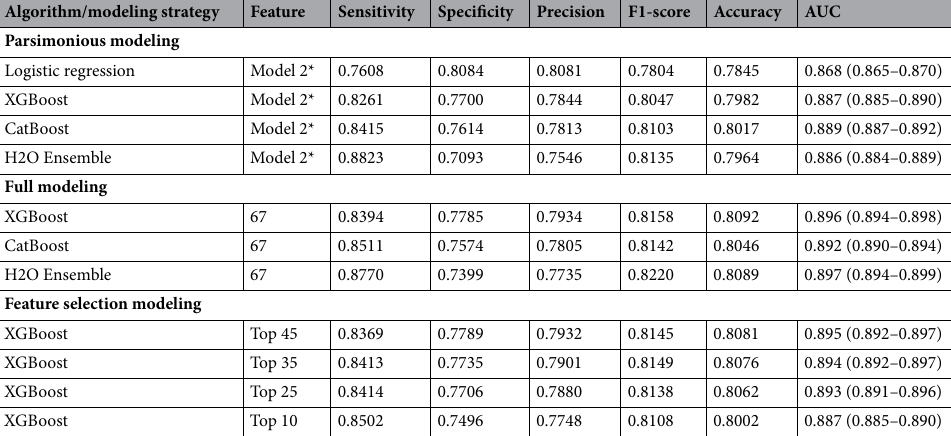
Table 3. Comparison of performance of determining fasting status by XGBoost, CatBoost, H 2 O Ensemble and logistic regression models in the testing dataset (n = 70,644). *Model 2 involves the features including glucose, age, male, timing of the day, interval between request and sampling, No. of outpatient visits, distance from home to hospital, division, hypertension, diabetes, coronary artery disease, stroke, statin use, and concomitant lipid testing as in Table 2.